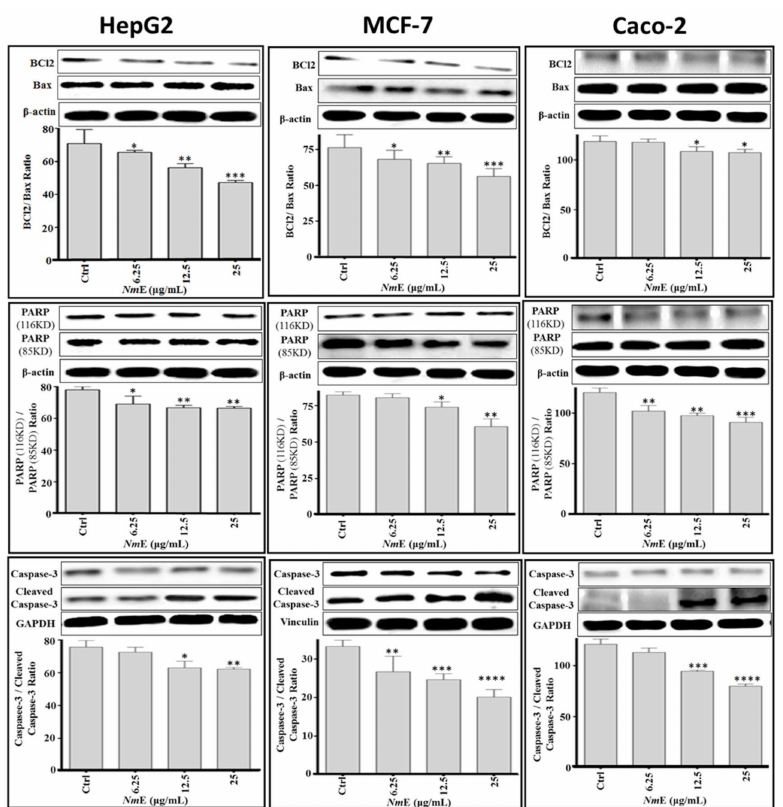
Figure 8. Effects of Nm E on protein expression of BCl2, Bax, cleaved PARP, and cleaved Caspase-3 in HepG2, MCF-7, and Caco-2 cells, which were treated with each Nm E concentration and harvested 48 h after treatments. The immunoblots shown are representative of three independent experiments, which all gave similar results, cropped and unedited images are provided here. Bars represent the means ± SD. * p < 0.05, ** p < 0.01, *** p < 0.001 and **** p <0.0001 vs. control (DMSO-treated)